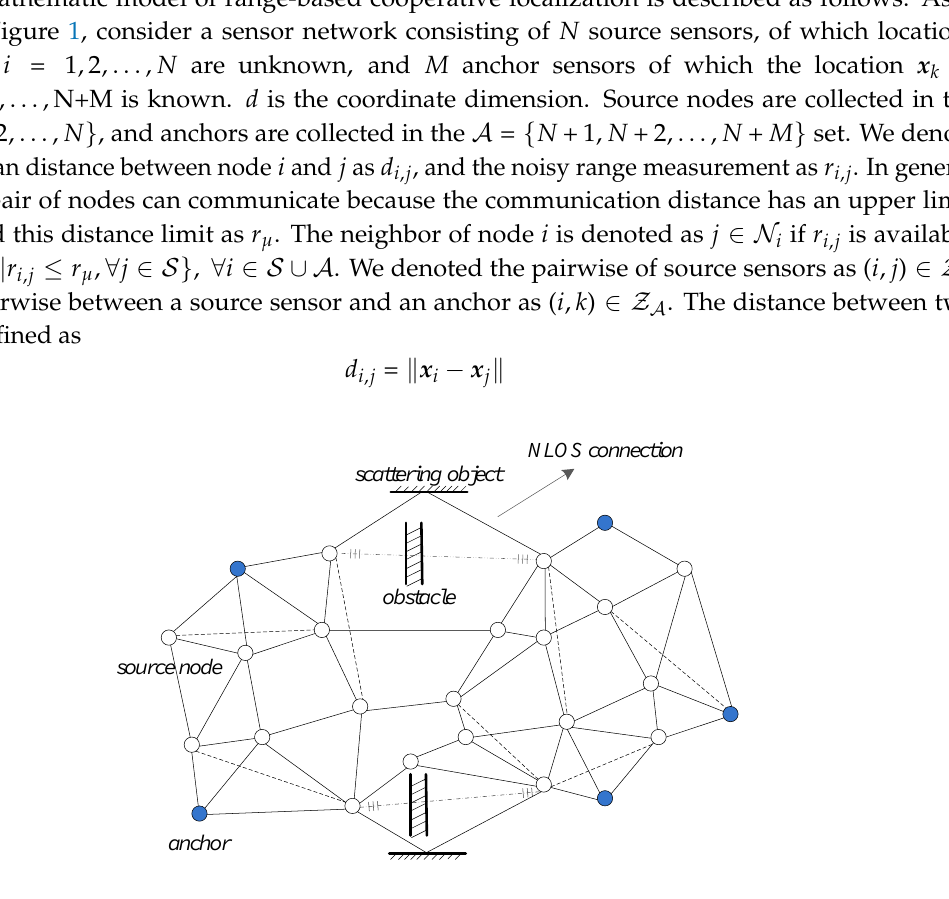
Figure 1. Wireless sensor network (WSN) figuration. Blue circles denote anchors; white circles denote source nodes. The physical model of non-line-of-sight (NLOS) connections is presented by obstacle and scattering object